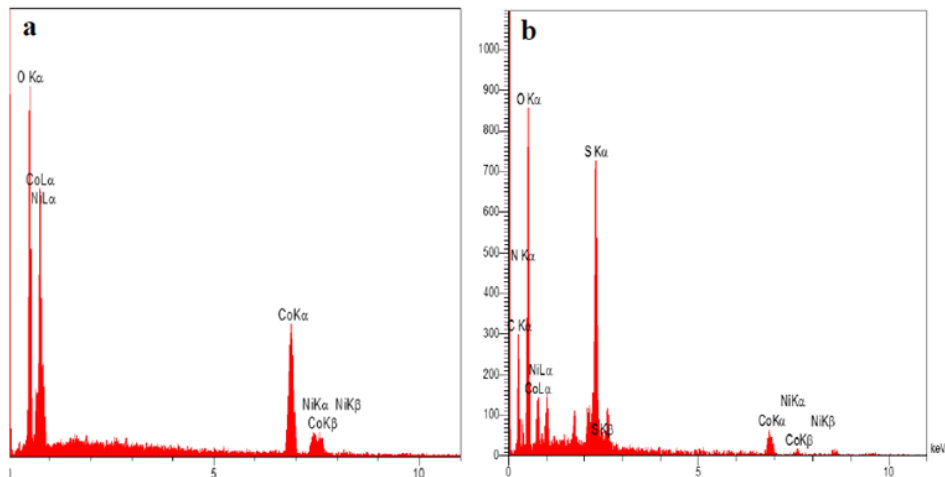
Fig 3. EDS spectrum of (a) Co 3 O 4 /NiO, and (b) Co 3 O 4 /NiO@GQDs @SO 3 H Fig. 3. EDS spectrum of (a) Co